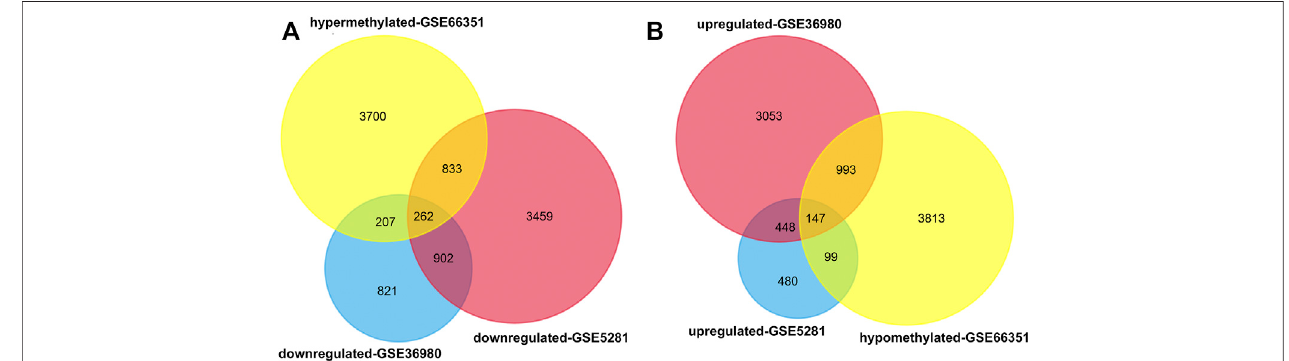
FIGURE 1 | Identi fi cation of aberrantly methylated and differentially expressed genes in temporal cortex of patients with AD. GEO2R was used to analyze the DNA methylation pro fi ling of methylation dataset 1 and gene expression pro fi ling of expression dataset 1 and 2. The aberrantly methylated genes and differentially expressed geneswereidenti fi edaccordingtothecutoffcriteria|t| > 2and p < 0.05.ThenVenndiagramanalysiswasperformedtoaberrantlymethylatedanddifferentiallyexpressed genes in the three datasets (A) Hypermethylated-downregulated genes (B) Hypomethylated-upregulated genes.